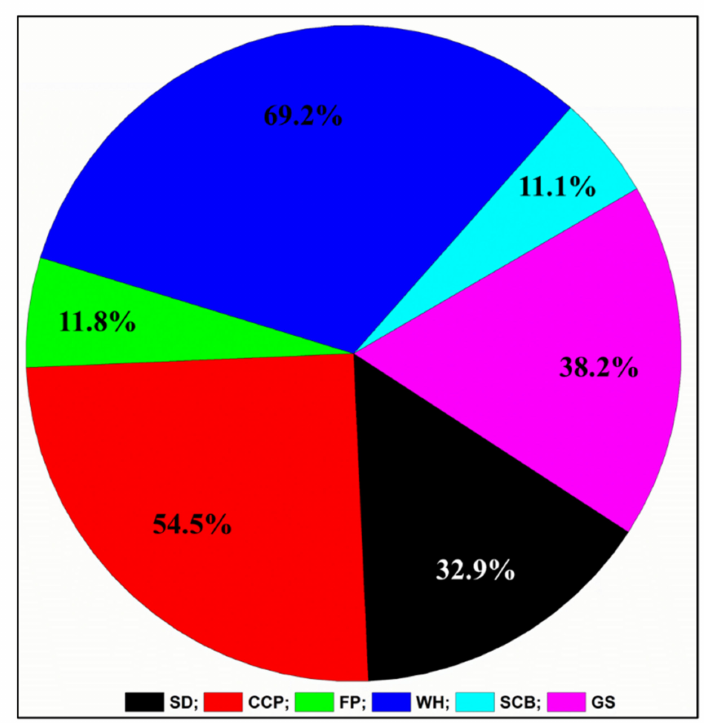
Figure 6. Percent (%) substrate degradation achieved with various agro-wastes by B. altitudinis RSP75. SD: sawdust; CCP: corn cob powder; FP: filter paper; WH: wheat husk; SCB: sugarcane bagasse; GS: grass